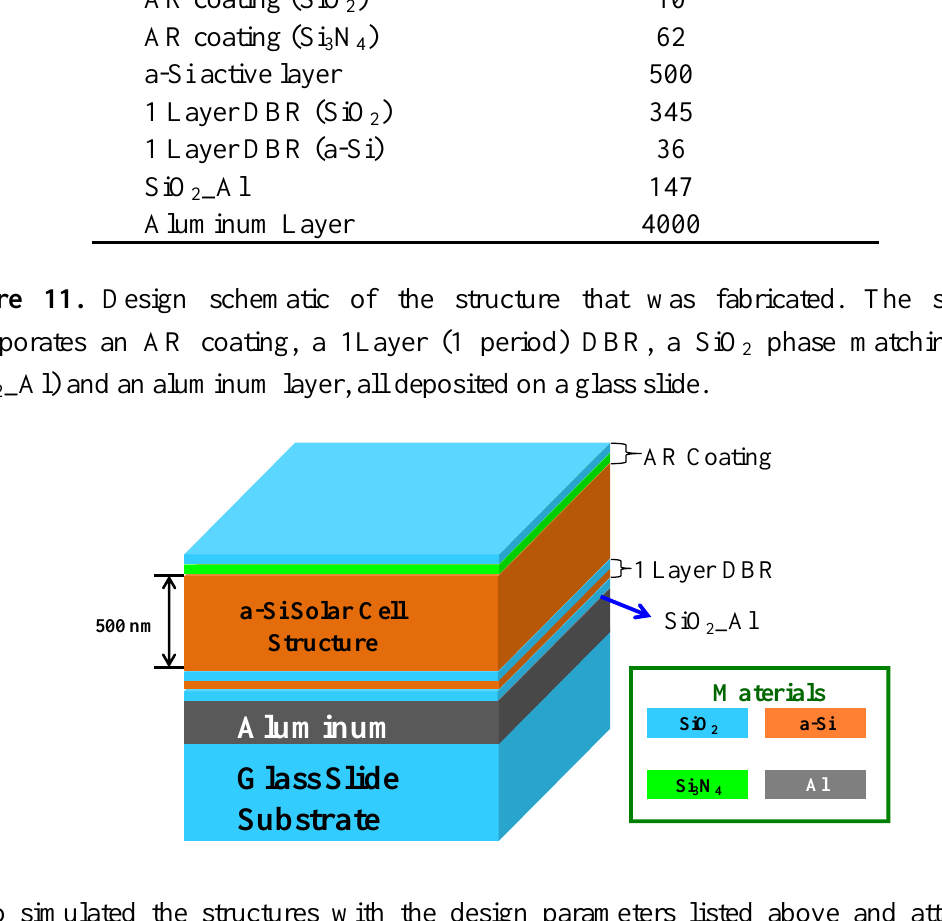
Table 2. Summary of optimal design parameters for the fabricated solar cell structures.